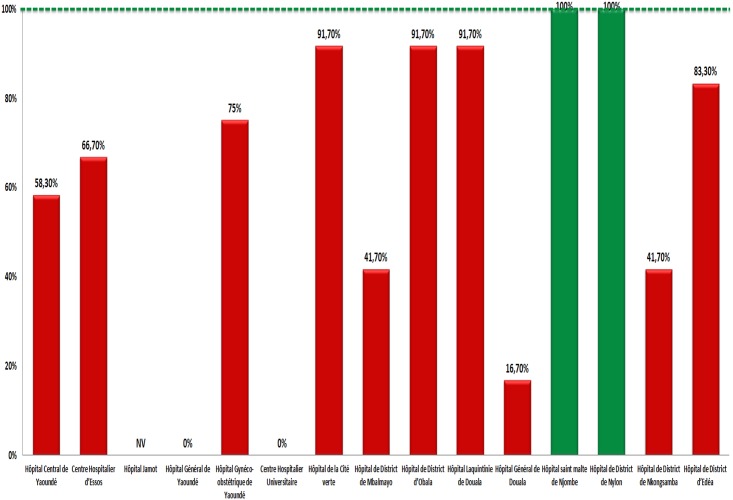
Site Performance for “No Pharmacy ARV Stock-outs” in 2013.NV, Not Validated; green, desirable performance; red, poor performance. The horizontal line in “green” color indicates the lower limit threshold for a “desirable” performance.